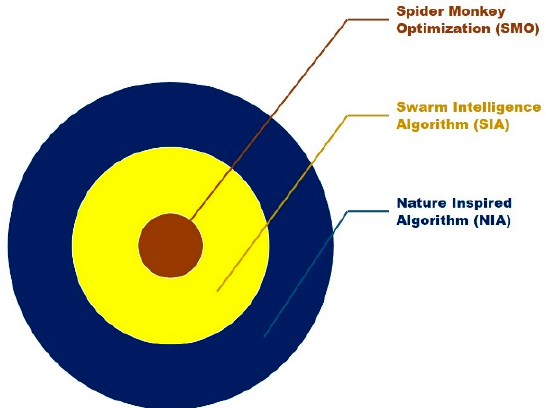
Figure 3. Relationship between spider monkey optimization (SMO), SIA and nature-inspired algorithms (NIA).